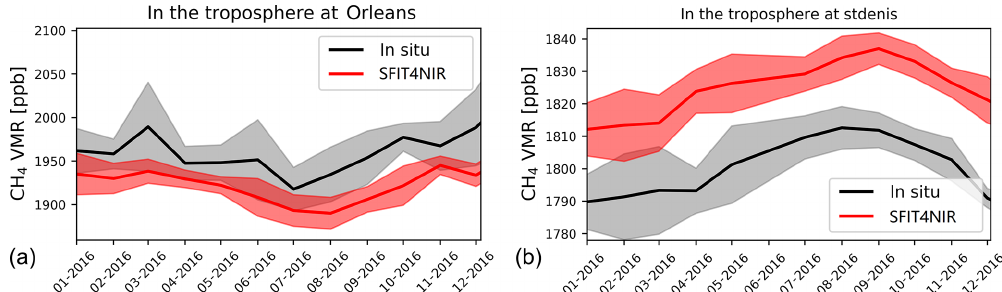
Figure 7. The time series of the monthly means (solid line) and standard deviations (shading) from the SFIT4NIR tropospheric X CH the ground-based in situ CH 4 measurements at Orléans (a) and at St Denis (b) . At Orléans, the in situ measurements are recorded at 180m on a tower at the same place. The in situ measurements at St Denis are recorded at 2155m on Maïdo mountain, which is about 20km away from St Denis.